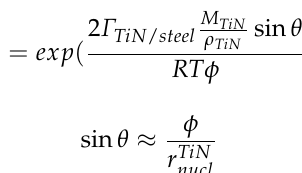
Figure 12. Influence of the cooling rate on the size distribution of MnS from calculations and experiments [64].